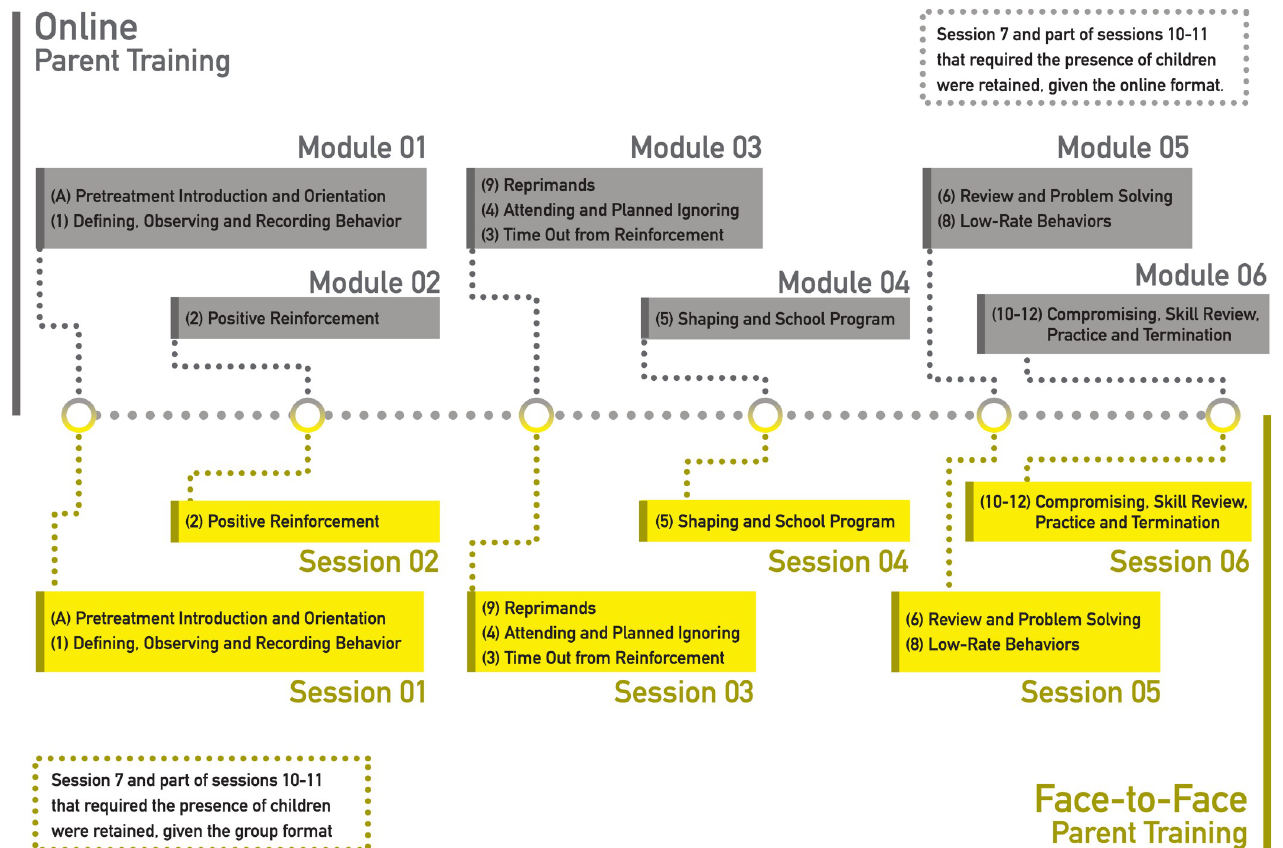
Fig 1. Parent training sessions/modules. Intervention adapted from the “Parent Manegement Training” manual developed by Alan Kazdin (2005).